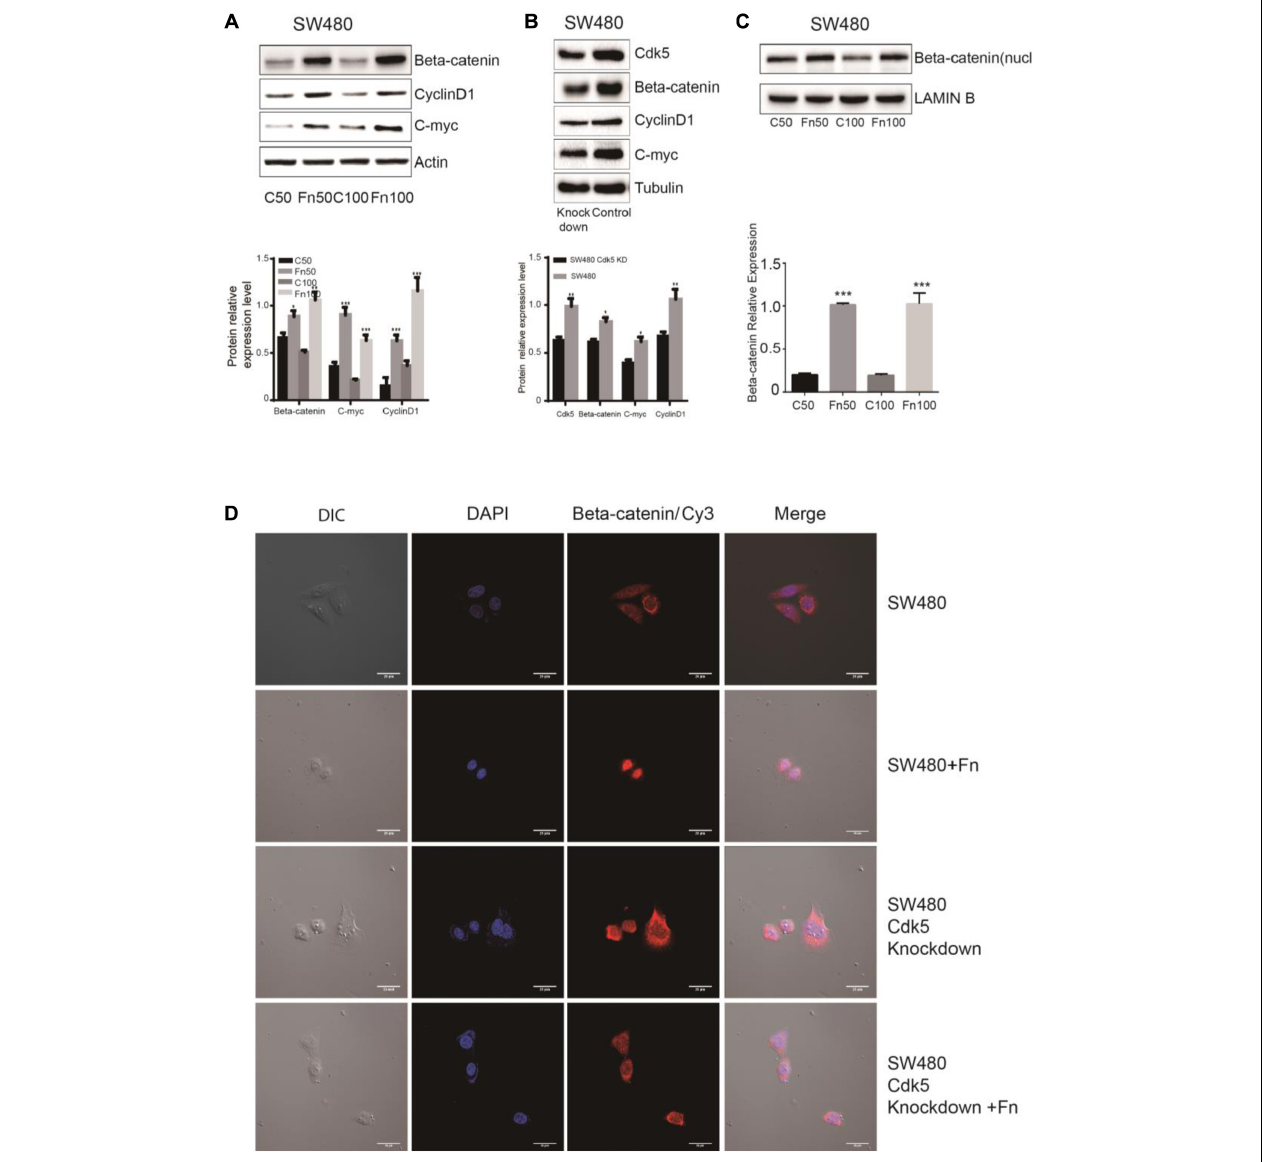
FIGURE 5 | Fusobacterium nucleatum activates Wnt/ β -catenin signaling and promotes the nuclear translocation of β -catenin through cyclin-dependent kinase 5 (Cdk5) in SW480 cell lines. (A) The expression levels and quantification of β catenin, c-Myc, and cyclin D1 treated with F. nucleatum were measured by Western blot (WB) analysis in SW480 cells. Data are expressed as mean ± SEM from at least three independent experiments. * P < 0.05, ** P < 0.01, and *** P < 0.001 vs. control. (B) The expression levels and quantification of Cdk5, β catenin, c-Myc, and cyclin D1 were measured by WB analysis in SW480 and Cdk5-knockdown SW480 cells. Data are expressed as mean ± SEM from at least three independent experiments. * P < 0.05 and ** P < 0.01 vs. control. (C) The expression levels and quantification of nuclear beta-catenin treated with F. nucleatum were measured by WB analysis in SW480 cells. Data are expressed as mean ± SEM from at least three independent experiments. *** P < 0.001 vs. control. (D) F. nucleatum affects β catenin cellular localization through Cdk5. Cells were seeded onto coverslips and treated with F. nucleatum or control for 12 h. The cells were then subjected to immunofluorescence staining. The cells were immunostained with an anti- β catenin (red fluorescence). The nucleus was stained with 4 (cid:48) ,6-diamidino-2-phenylindole (DAPI) (blue fluorescence). Cy, cyanine; DIC, differential interference